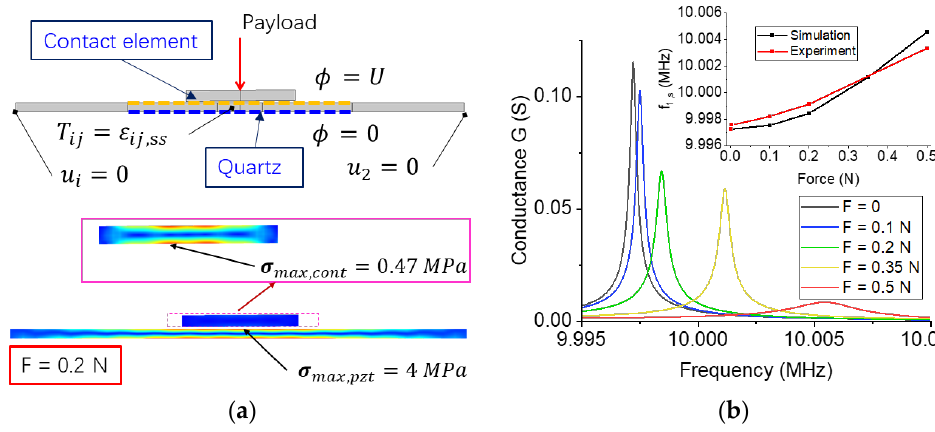
Figure 4. The numerical model of contact between a quartz wafer and a ceramic sheet. ( a ) The boundary conditions and model. ( b ) The conductance of wafer when different payloads are applied to the contact unit.